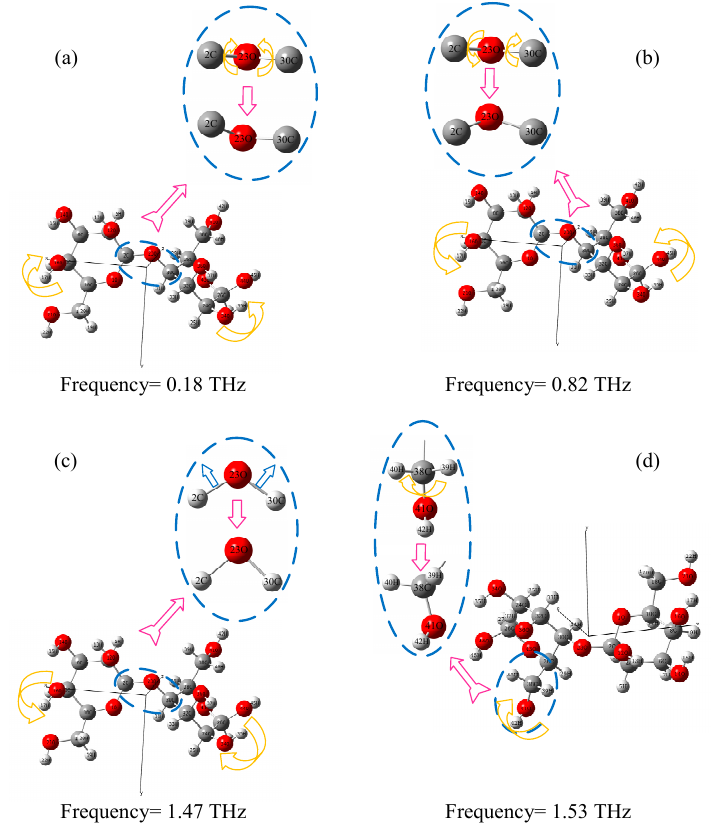
Figure 7. The assignment of simulated absorption peaks of insulation paper. ( a ) peak at 0.18 THz; ( b ) peak at 0.82 THz; ( c ) peak at 1.47 THz; ( d ) peak at 1.53 THz.